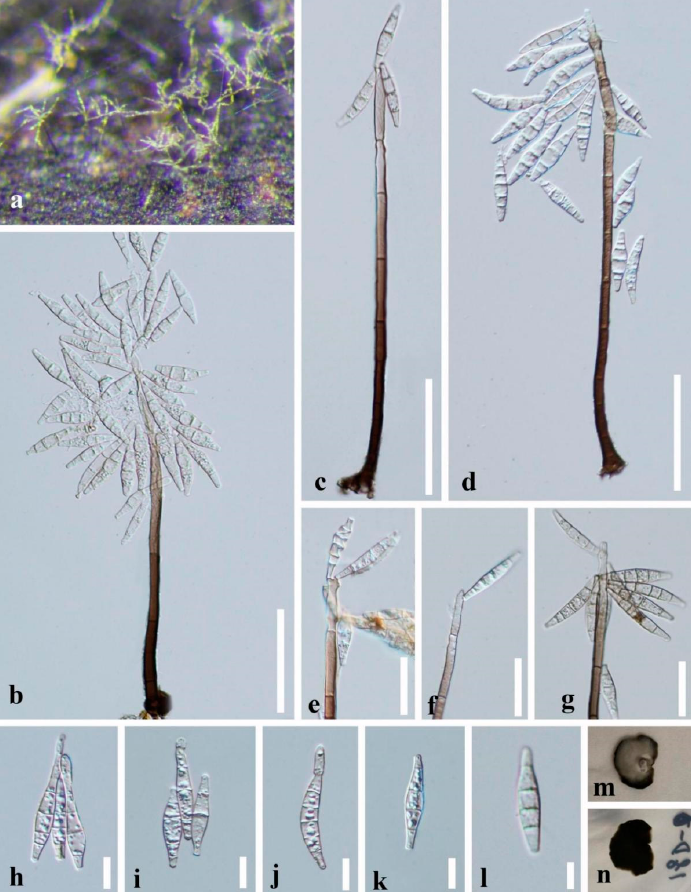
Figure 2. Paramirandina aquatica (GZAAS 20-0303, holotype ). ( a ) Colony on wood. ( b – d ) Conidio- phores and conidia. ( e – g ) Conidiogenous cells and conidia. ( h – l ) Conidia. ( m , n ) Culture, m from above, n from below. Scale bars: ( b – d ) = 50 μ m, ( e – g ) = 25 μ m, ( h – l ) = 10 μ m.